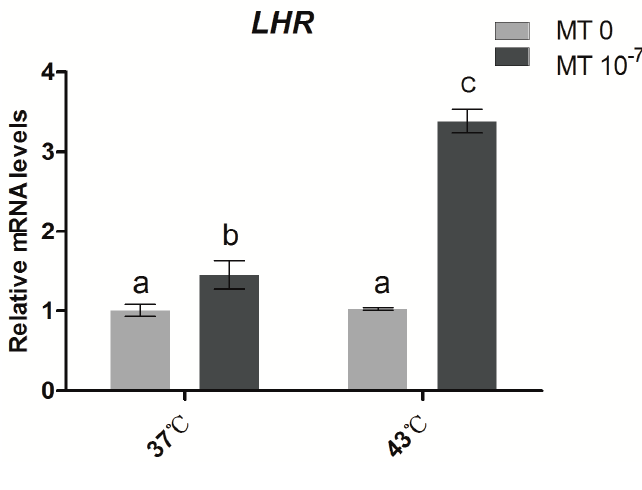
Figure 5. Effects of melatonin on the relative expression of LHR in sheep granulosa cells MT: melatonin. Each bar represents the mean ± SEM for experiments performed in triplicate. Different letters in the same column represent significant differences, p <